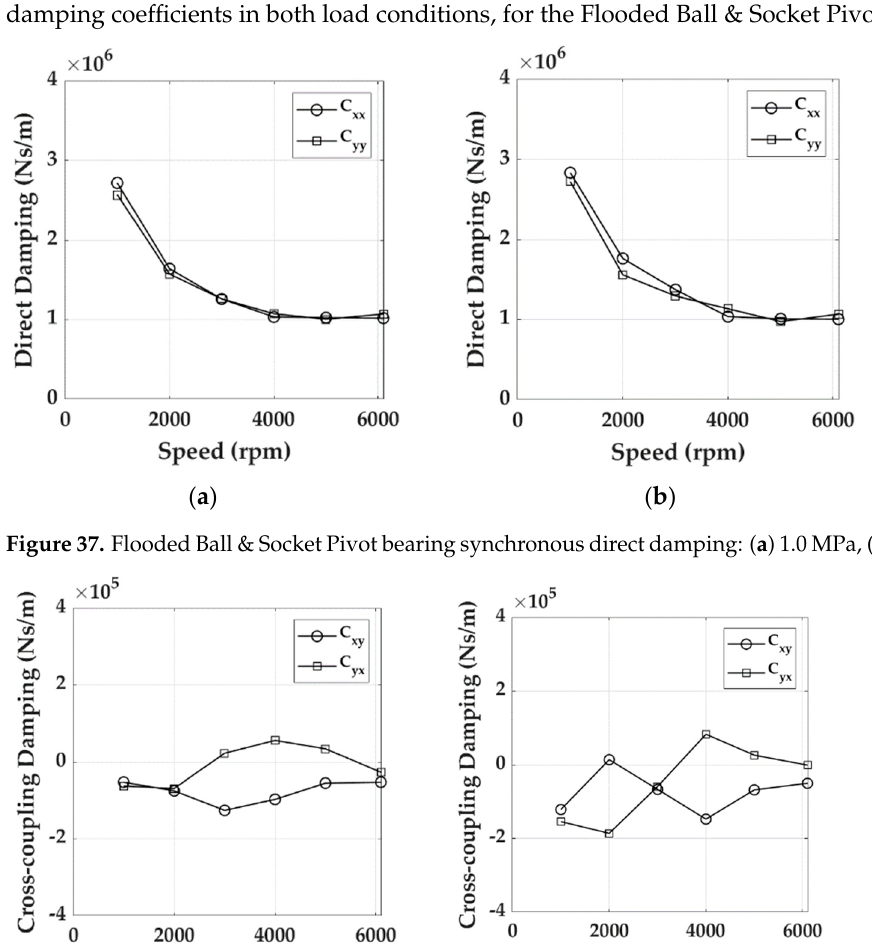
( b ) Figure 36. Flooded Rocker Pivot bearing synchronous cross-coupling damping: ( a ) 1.3 MPa, ( b ) 2.1